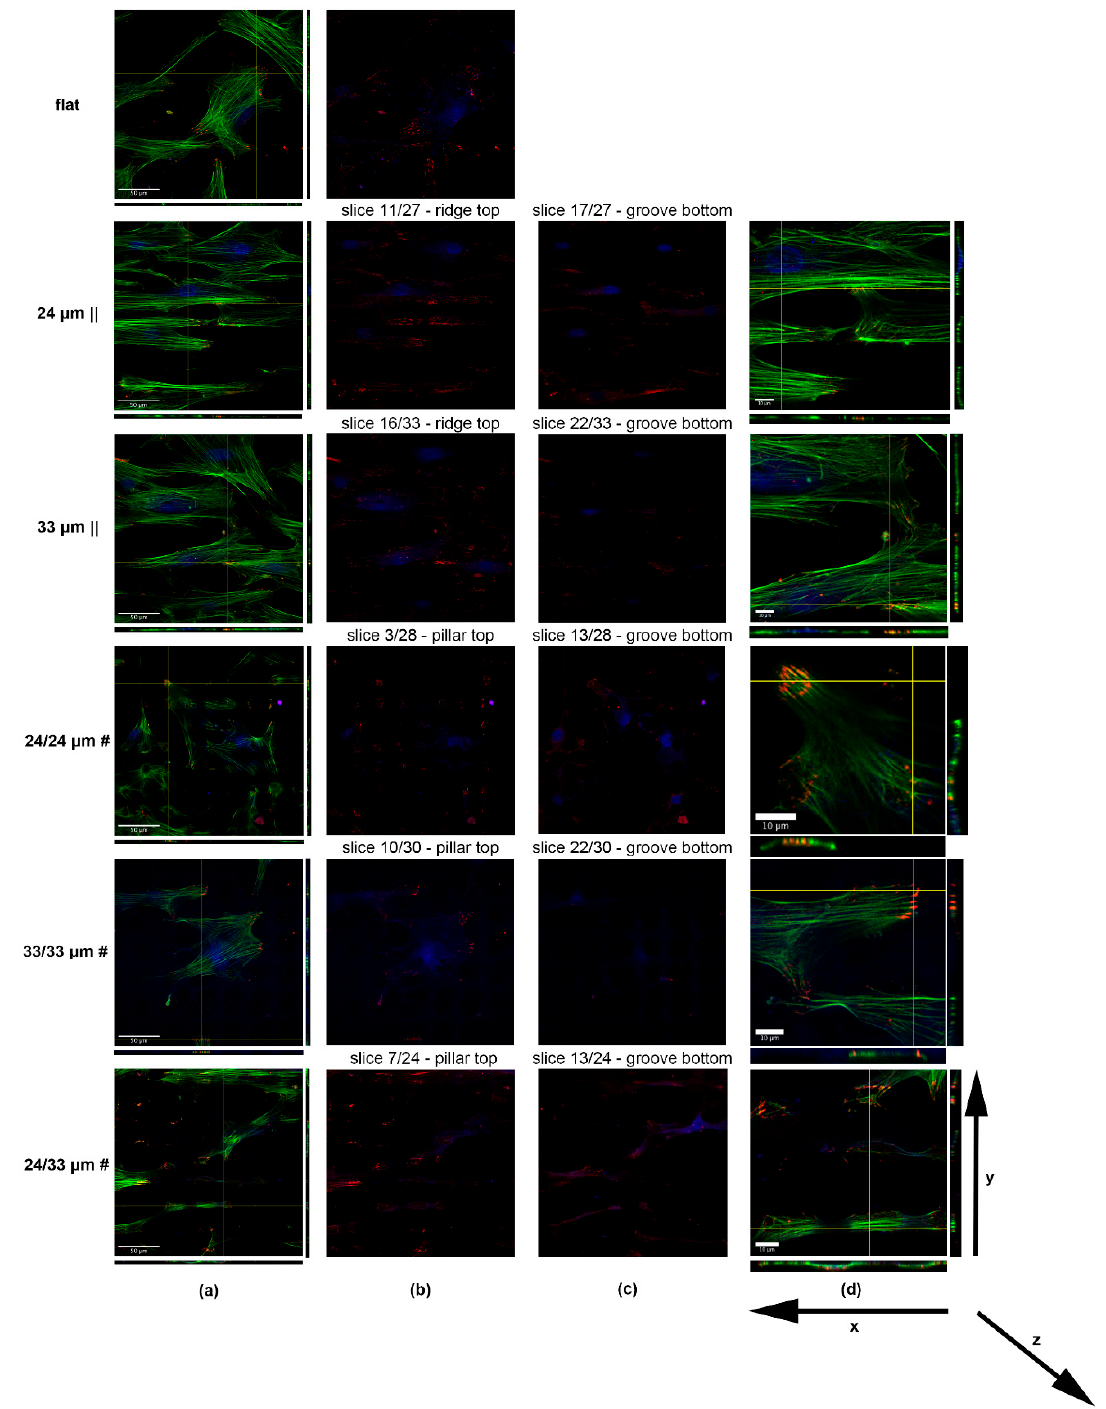
Figure6. Confocalimages( a )andorthogonalslices( b , c )depictingfocalcontactsofhumanmesenchymal stromal / stem cells hMSCs with the top ( b ) and bottom ( c ) structures of the Zirconia microtopographies. Representative cells are shown to depict the zyxin-labeled focal adhesions. Detailed views of single cells and orthogonal slicing thereof are provided in ( d ). Image acquisition was performed using the Zeiss LSM-710 laser scanning